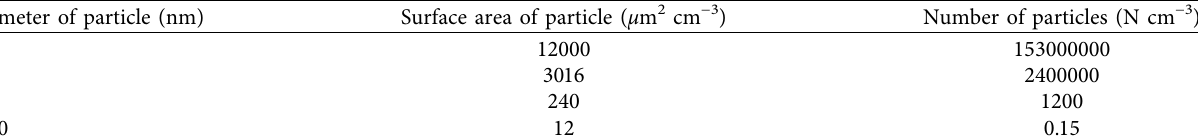
Table 1: Particle size, surface area, and number.